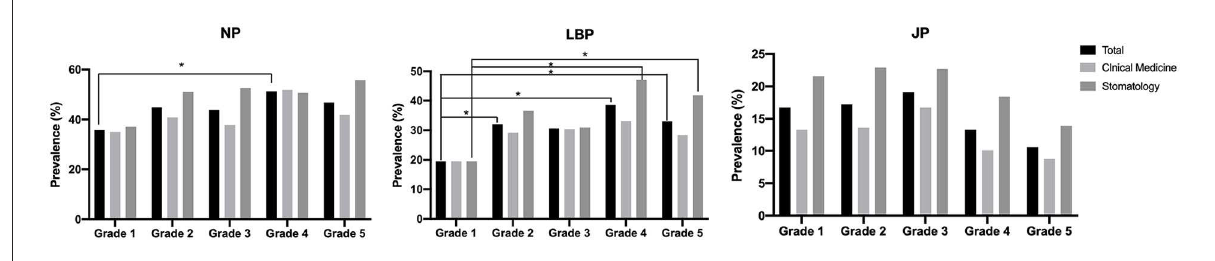
FIGURE1 Cross-grade differences of musculoskeletal pain (*: significant